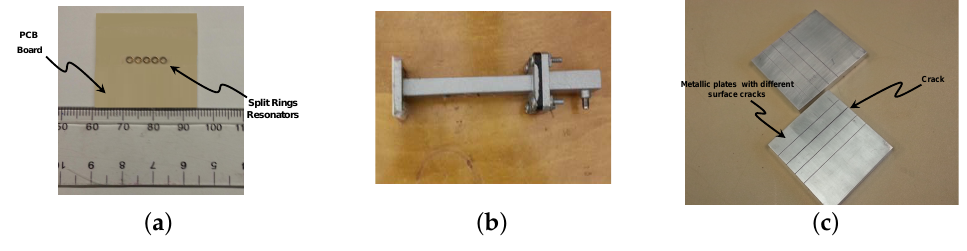
Figure 2. Photographs of the sensor. ( a ) used waveguide sensor side view; ( b ) printed circuit board (PCB) with split ring resonators; ( c ) a photograph of metallic plates with different cracks.